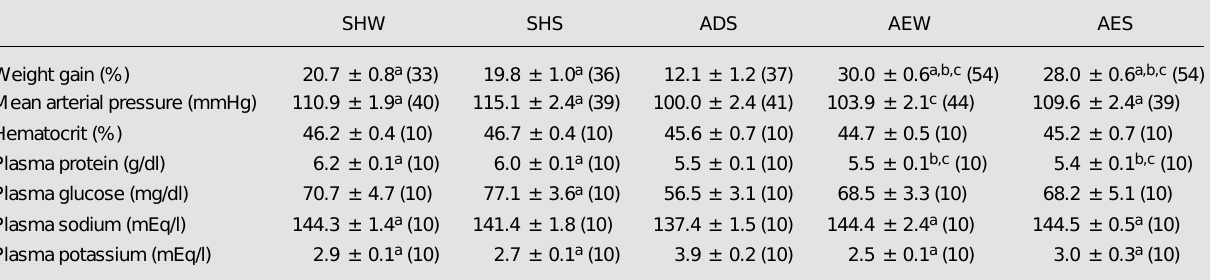
Table 1 - Weight gain, mean arterial pressure, hematocrit, plasma protein, glucose, sodium and potassium levels for the subgroups of rats studied. The data are reported as means ± SEM. The number of animals is given in parentheses. a P<0.05 compared to ADS; b P<0.05 compared to SHW; c P<0.05 compared to SHS (Tukey test). AD, Adrenalectomized; AE, adrenal enucleated; SH, sham operated. The third letter in each abbreviation refers to tap water (W) or 1% saline